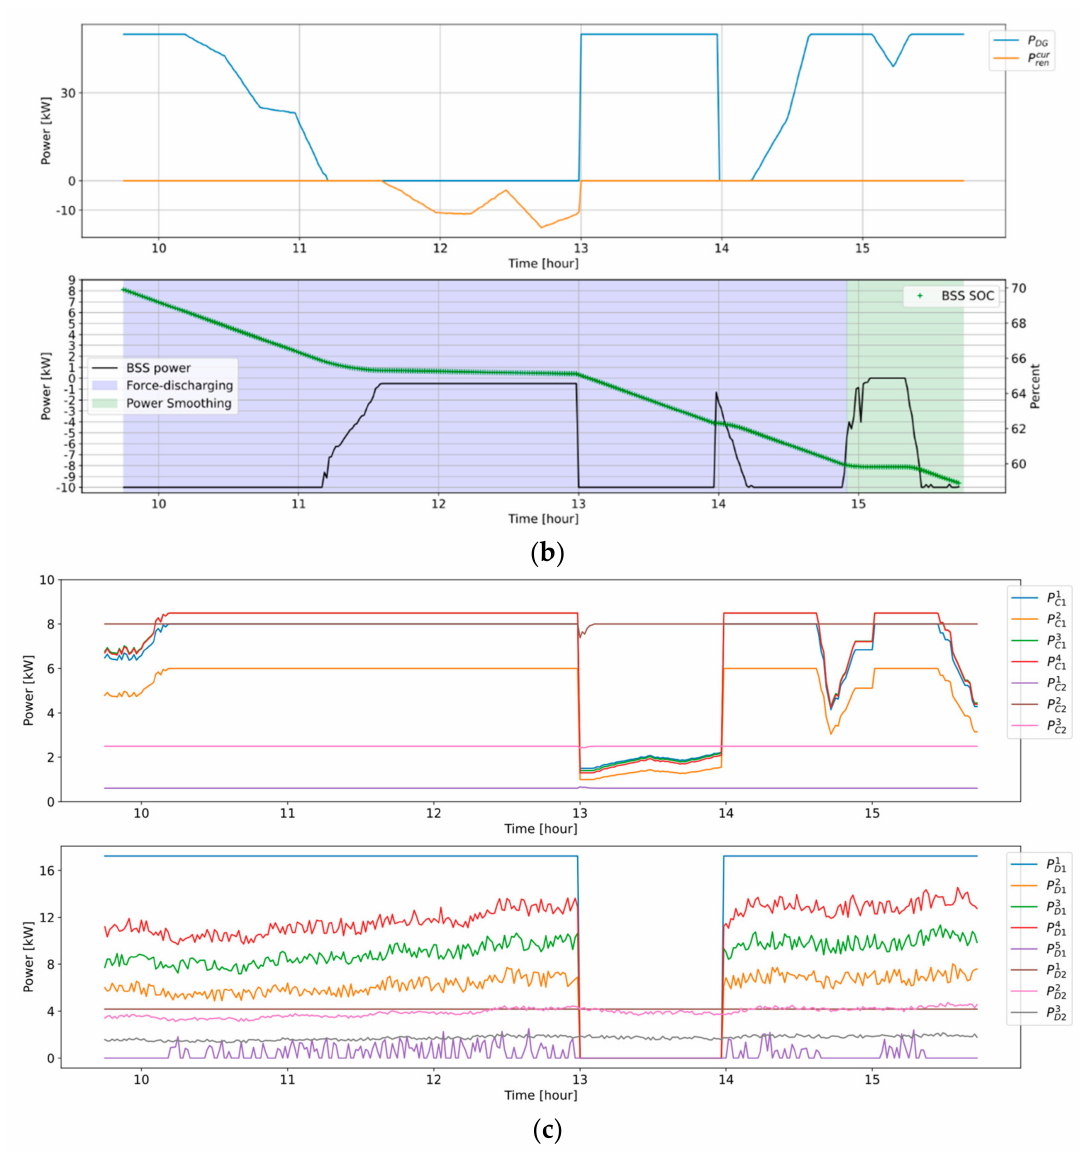
Figure 19. Test results of Case-e: The PV system is tripped at 1 PM for one hour. ( a ) Variation of the total load demand and PV generation. ( b ) Variation of the DG power output, curtailed PV generation, BSS SOC, BSS energy, and obtained dispatch rules during the test. ( c ) Illustration of power of individual DCLs and CCLs through the